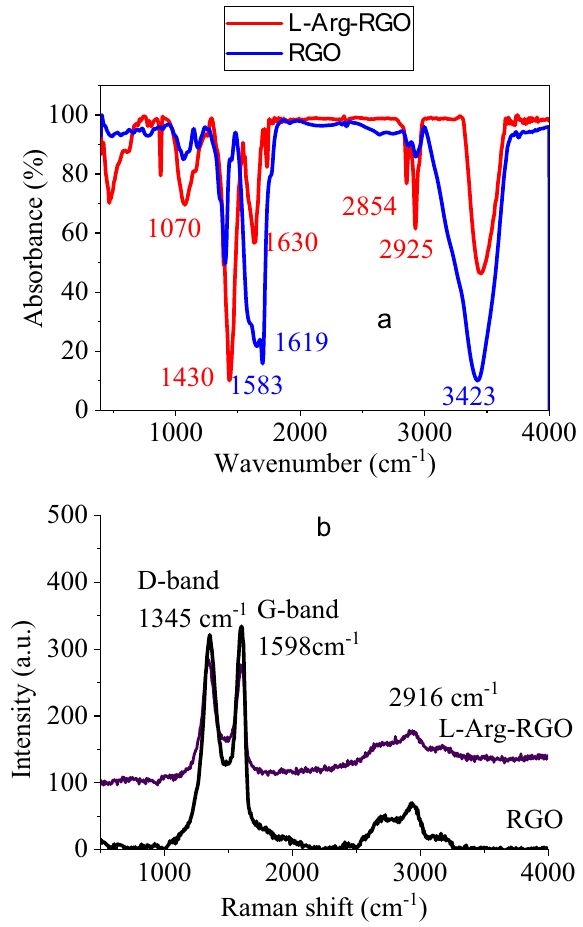
Figure 2. FT-IR spectra ( a ), and Raman spectra ( b ) of RGO and